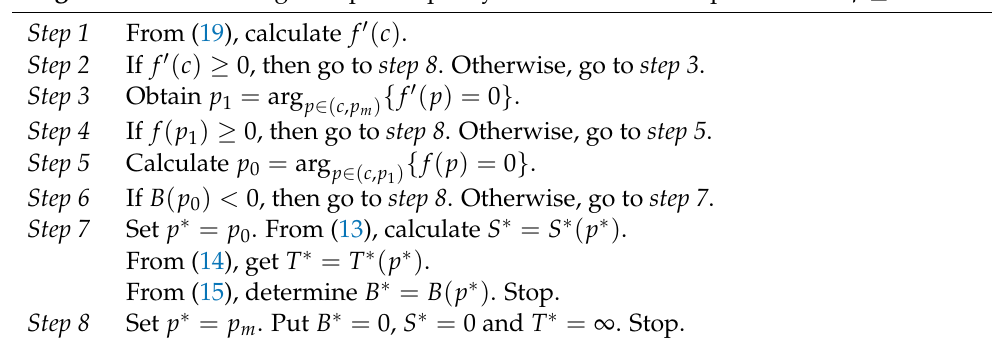
Algorithm 1 Obtaining the optimal policy and the maximum profit when γ ≥